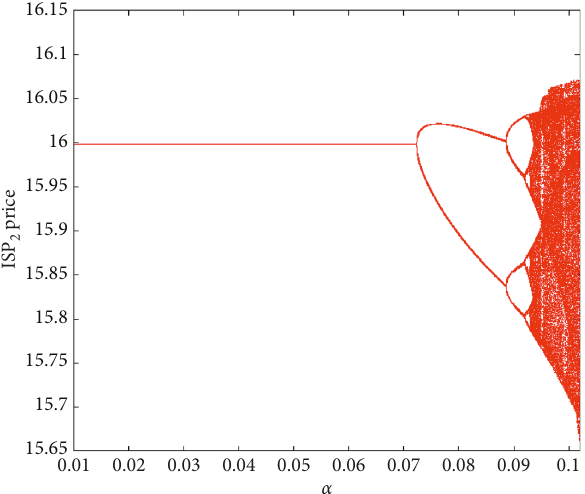
Figure 8: Bifurcation diagrams of p